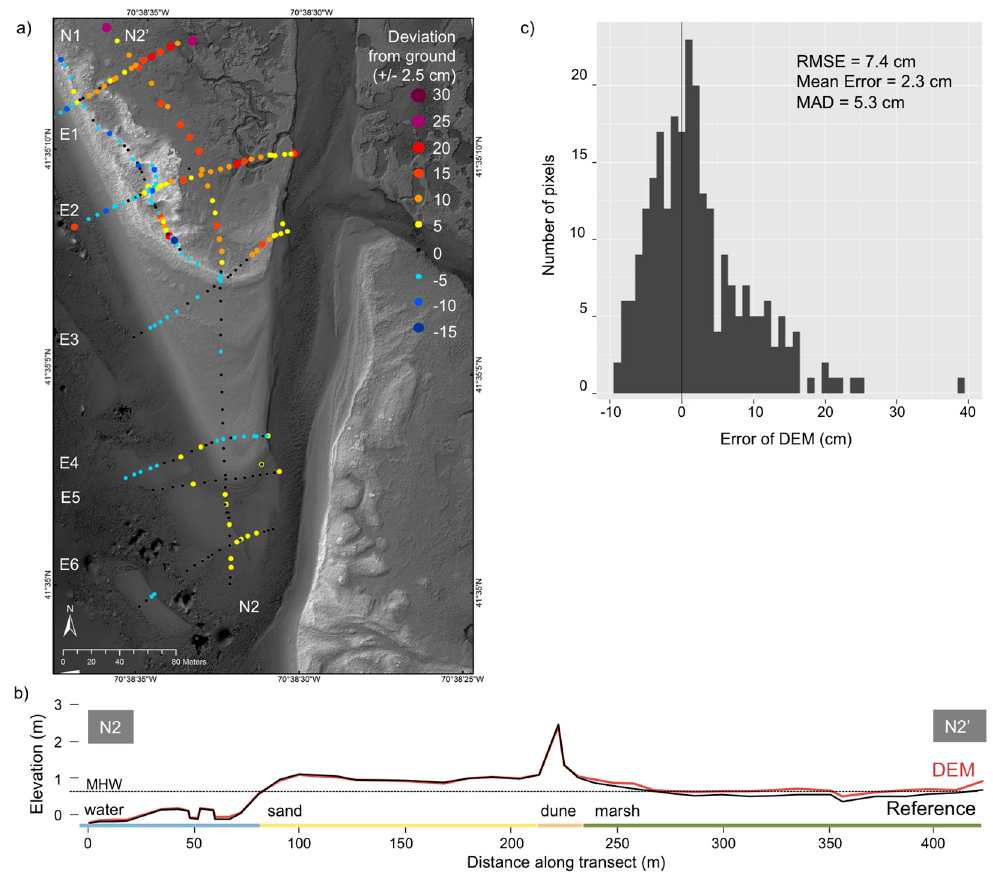
Figure 6. Deviation of DEM elevation from GNSS-surveyed reference elevations. ( a ) Reference points displayed on the DEM and symbolized by DEM deviation: small black points indicate an absolute deviation of less than 2.5 cm; blue and larger points represent increasingly negative deviation (where DEM measured lower elevation than reference); warm colors and larger points represent increasingly positive deviation (where DEM measured higher elevation than reference). ( b ) Elevation (m) along Transect N2 measured at reference points (black) and by the SfM DEM (red). The vertical root mean square error (RMSE Z ) for Transect N2 is 7.7 cm. ( c ) Histogram of DEM deviations from reference elevations; bin width is 1 cm and the black vertical line indicates no deviation. Table 1. Vertical accuracy by land cover presented as mean error, mean absolute deviation (MAD), and RMSE Z . Points were classified from the final 15-cm thematic map and manually verified. “Marsh” includes wetland vegetation; “Herbaceous Vegetation” includes non-marsh herbaceous vegetation; and “Shrub” includes woody vegetation.